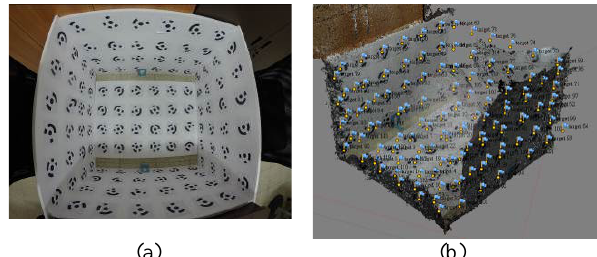
Figure 5. Configuration of cameras alignment: (a) distribution of markers; (b) result of bundle adjustment.